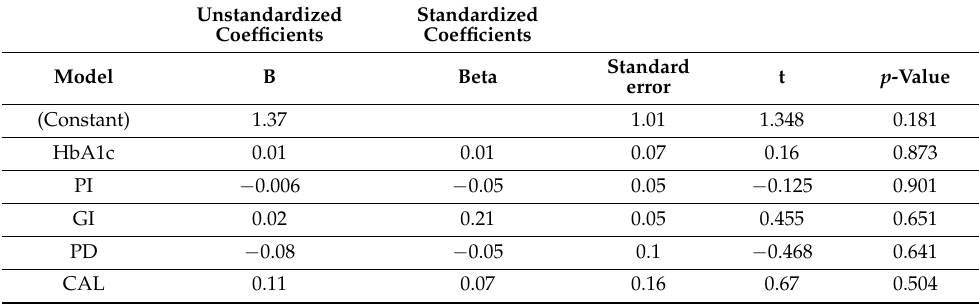
Table 8. The individual